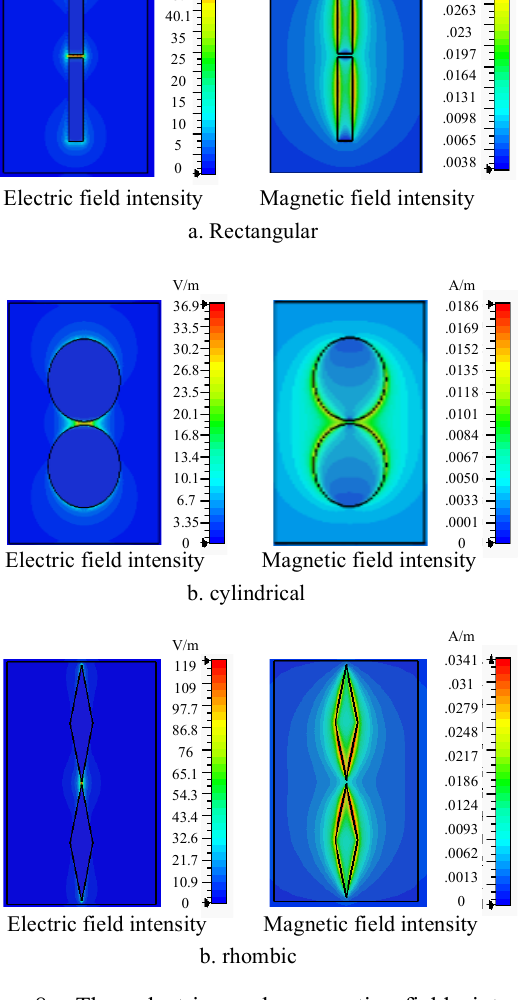
Figure 8. The electric and magnetic field intensity distribution on different shapes of IR nanoantennas.